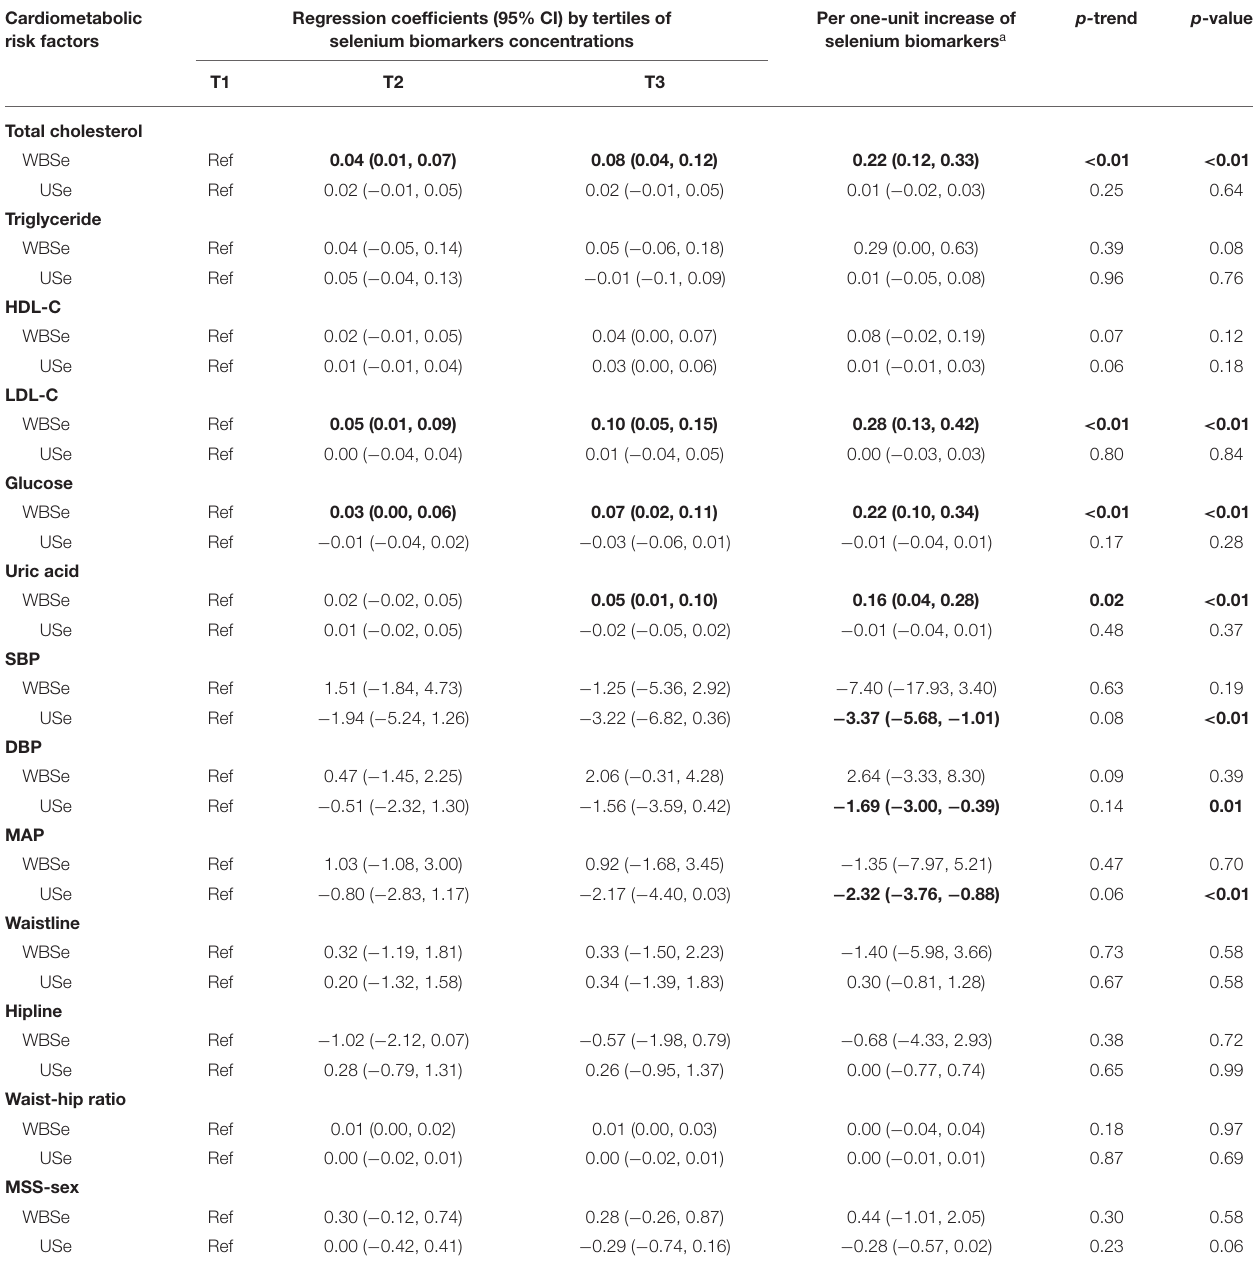
TABLE 4 | Associations of selenium biomarkers with cardiometabolic risk factors, analyzed using linear mixed-effects regression models. Cardiometabolic risk